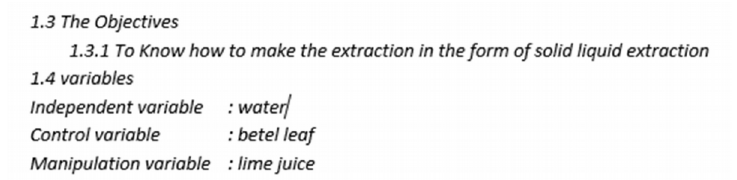
Figure 7. examples of student answers who got a score of 2 in writing